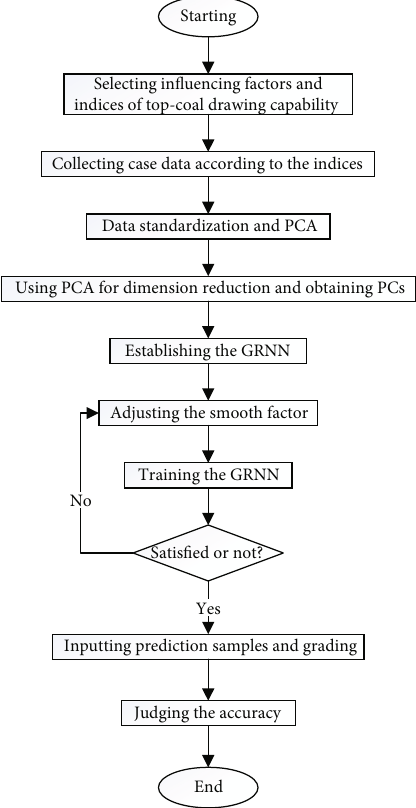
Figure 2: Flowchart of the prediction model for top-coal drawing capability in steep seams.